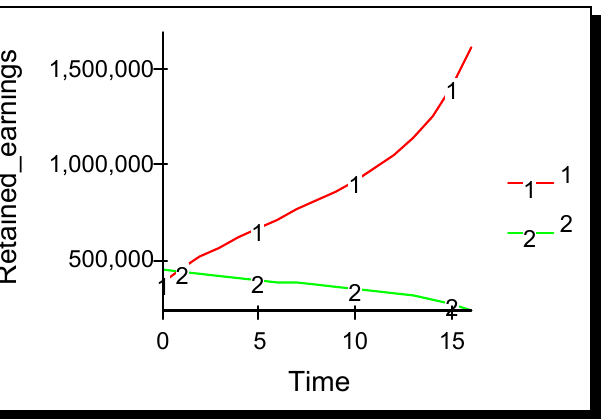
Figure 1. Unilateral advertising, above threshold. Advertising effectiveness: φ 1 = 0.000011; φ 2 = 0.